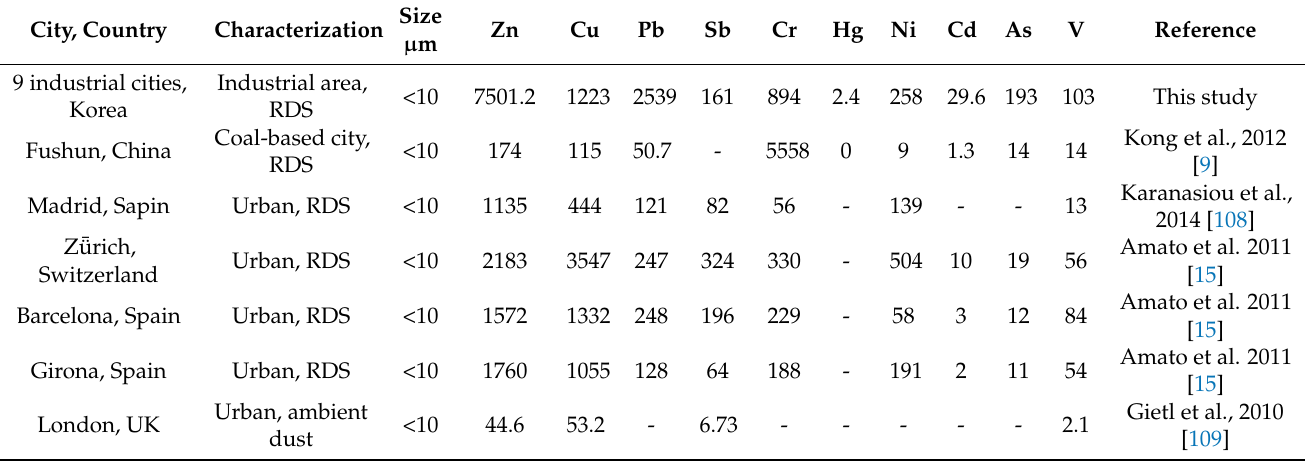
Table 4. Mean levels of HMs concentrations in PM10 of RDS in several previous studies. (unit. mg/kg). City,